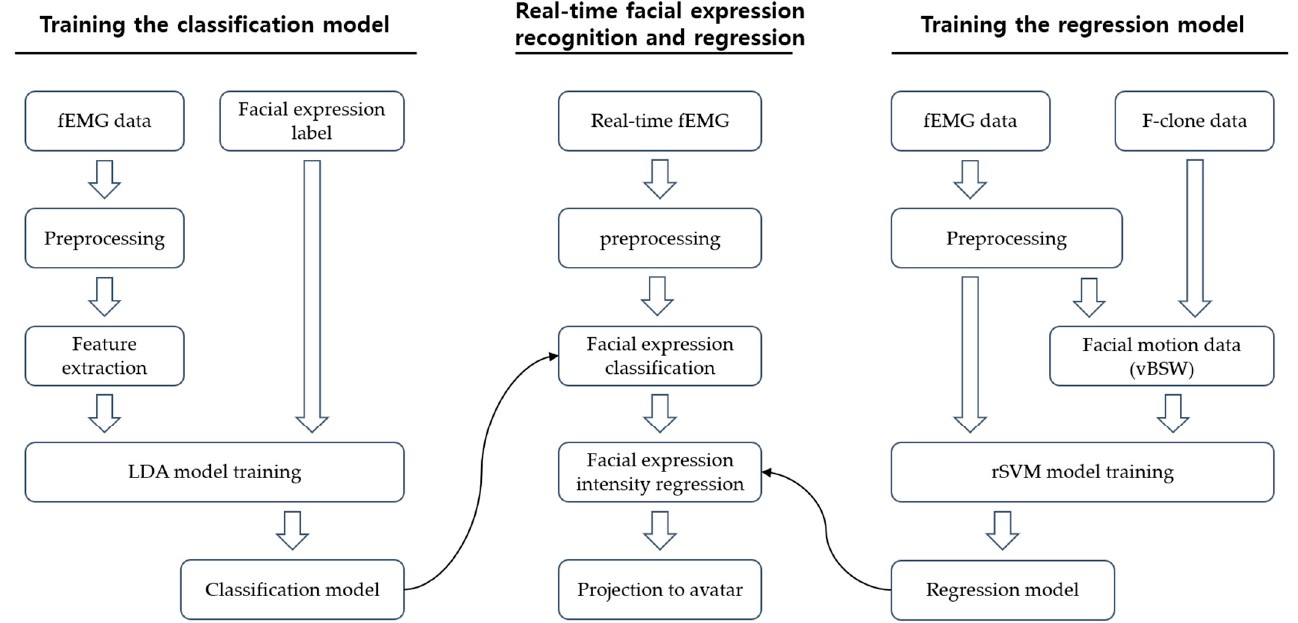
Figure 3. Overall procedure of the facial expression prediction system. Left panel presents the sequence of classification model training. Right panel presents the sequence of regression model training. Middle panel presents the process for real-time facial expression recognition and projection of the predicted facial expression and its intensity onto the avatar face.